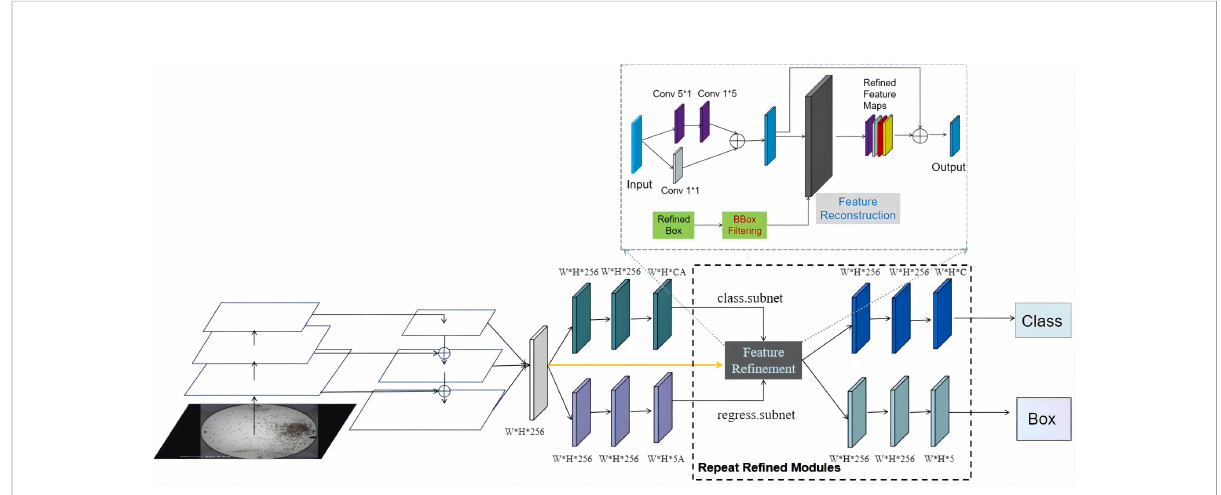
FIGURE 5 The network structure diagram of the rotation detection algorithm used in this